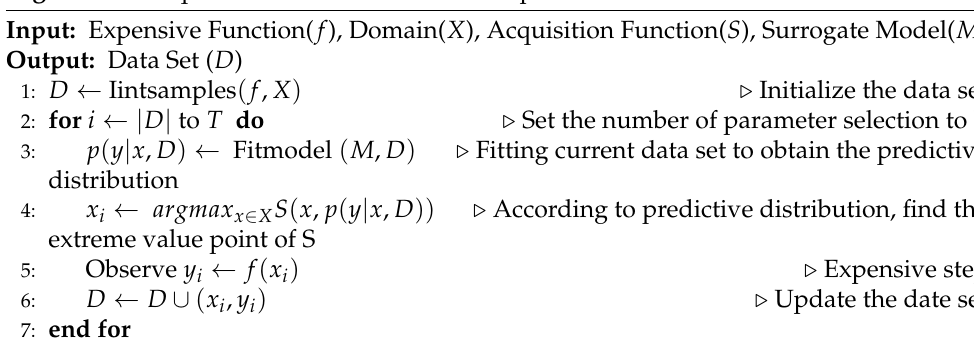
Algorithm 1 Sequential Model-based Global